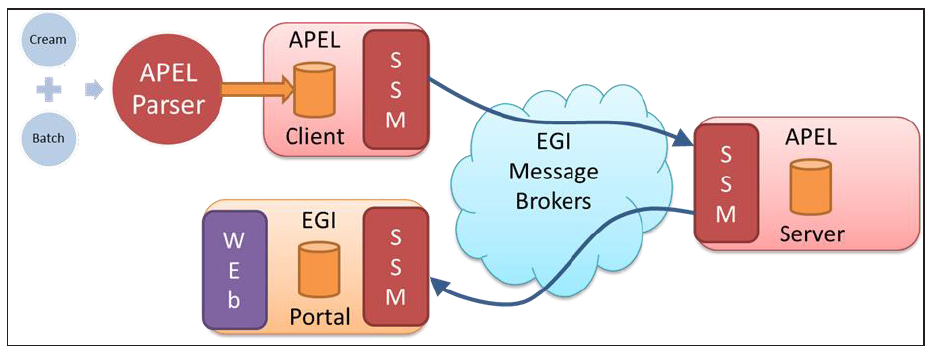
Fig. 1. The current accounting system showing an example data flow from a grid batch system through to the web portal provide by the EGI Accounting Portal. All “APEL” and “SSM” components were developed by the APEL